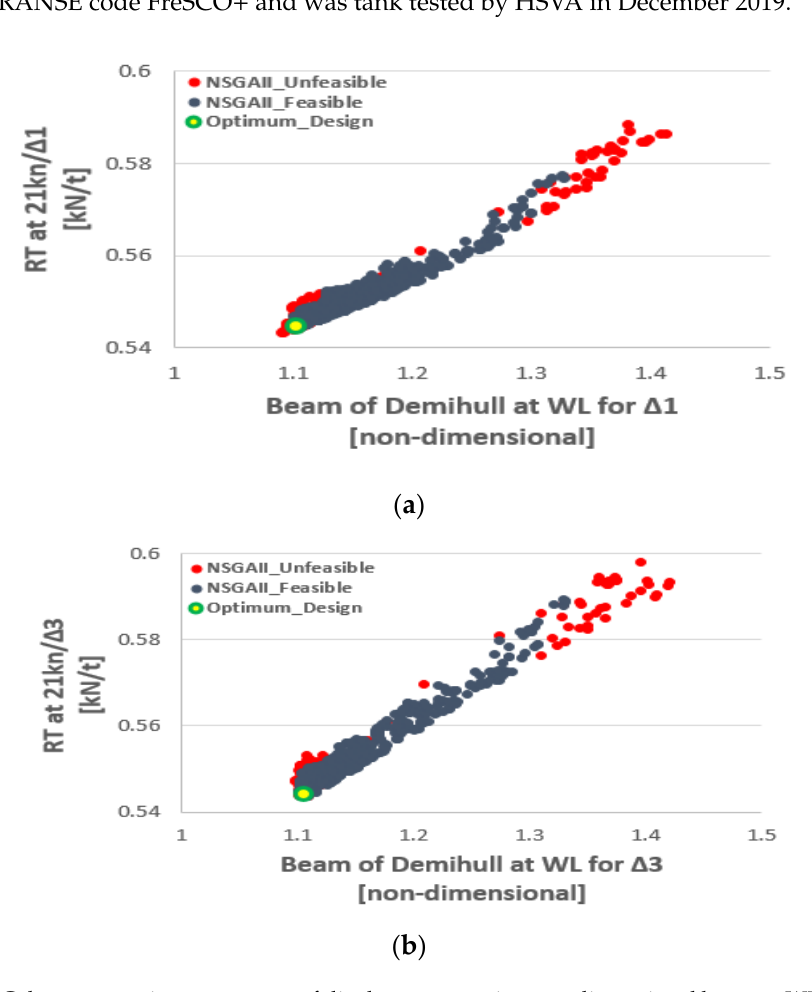
Figure 6. Calm water resistance per ton of displacement against nondimensional beam at WL at 21 kn for ( a ) Δ1 and ( b ) Δ3.